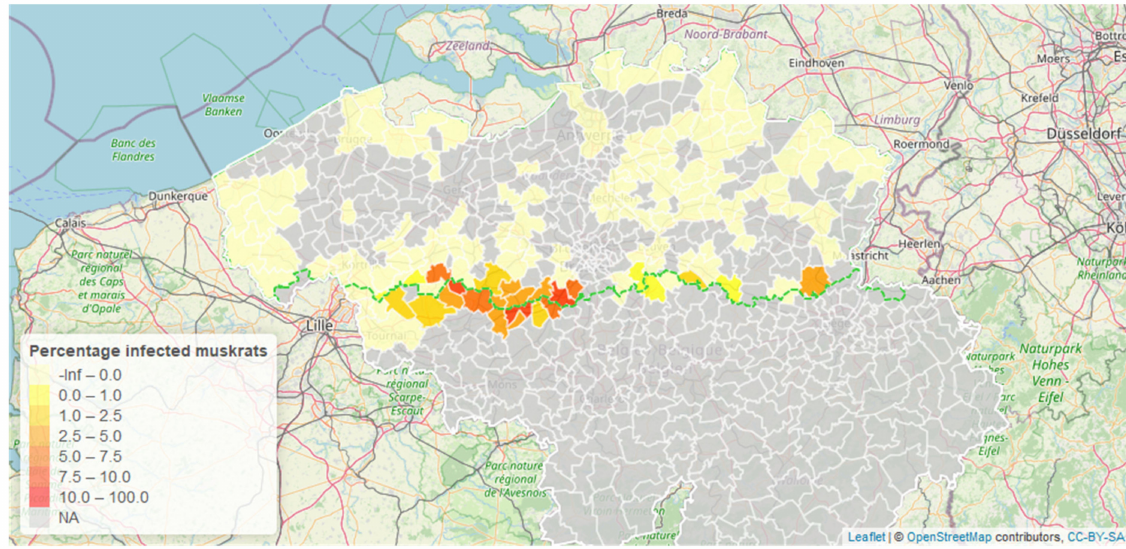
Figure 2. Percentage of infected muskrats out of all animals dissected between 2009 and 2017. Additional observations from Wallonia (regional border indicated by green dashed line) are also included.